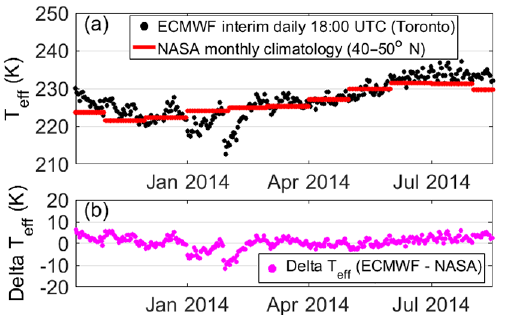
Figure 9. Effective ozone temperature: (a) T eff calculated using ECMWF ERA-Interim data (18:00UTC over Toronto) and NASA climatology data (monthly mean for 40–50 ◦ N), and (b) the differ- ence between these two.